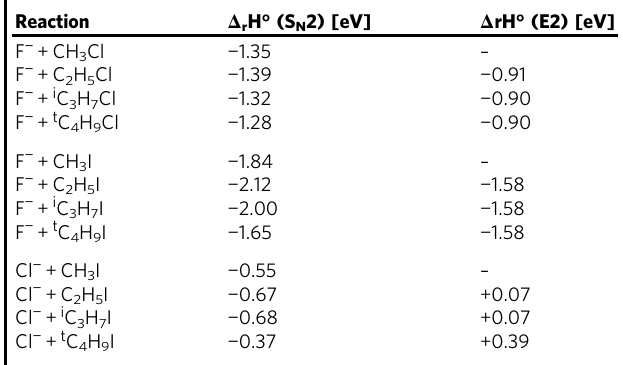
Table 1 Substitution and elimination reaction enthalpies